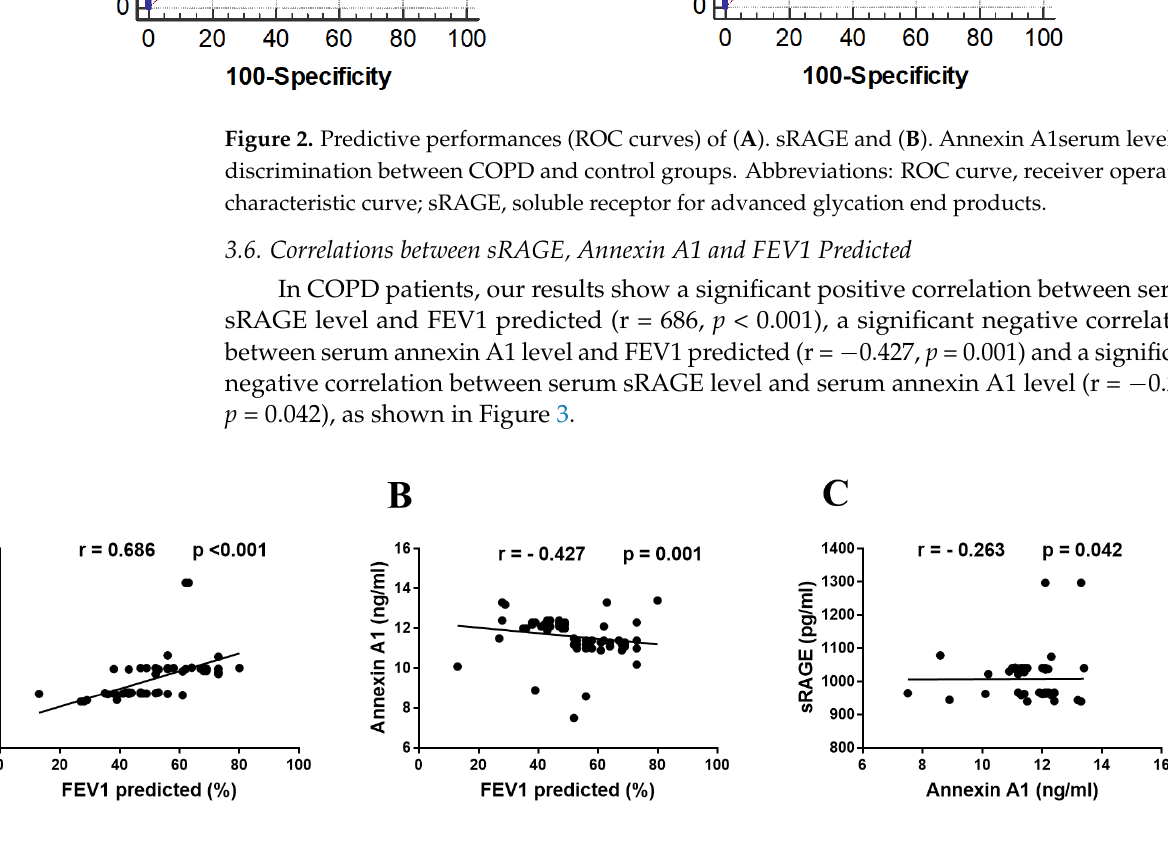
Figure 3. Correlations in COPD patients between ( A ). sRAGE and FEV1; ( B ). annexin A1 and FEV1; ( C ). sRAGE and annexin A1. Abbreviations: FEV1, forced expiratory volume in the first second; sRAGE, soluble receptor for advanced glycation end products.